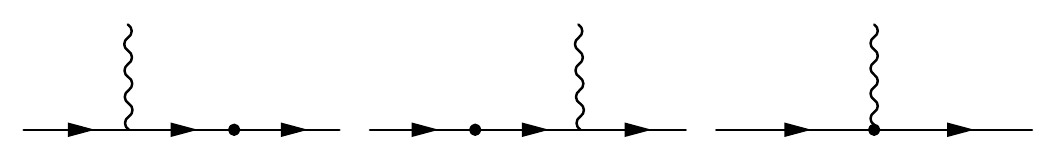
Figure 1 . Contributions to the neutron EDM induced by CP-violating Weinberg-type operators. The dotted vertices indicate operator insertions and the solid lines represent propagators of the neutron n or the excited states N 0 and N 00 . See text for further explanations.